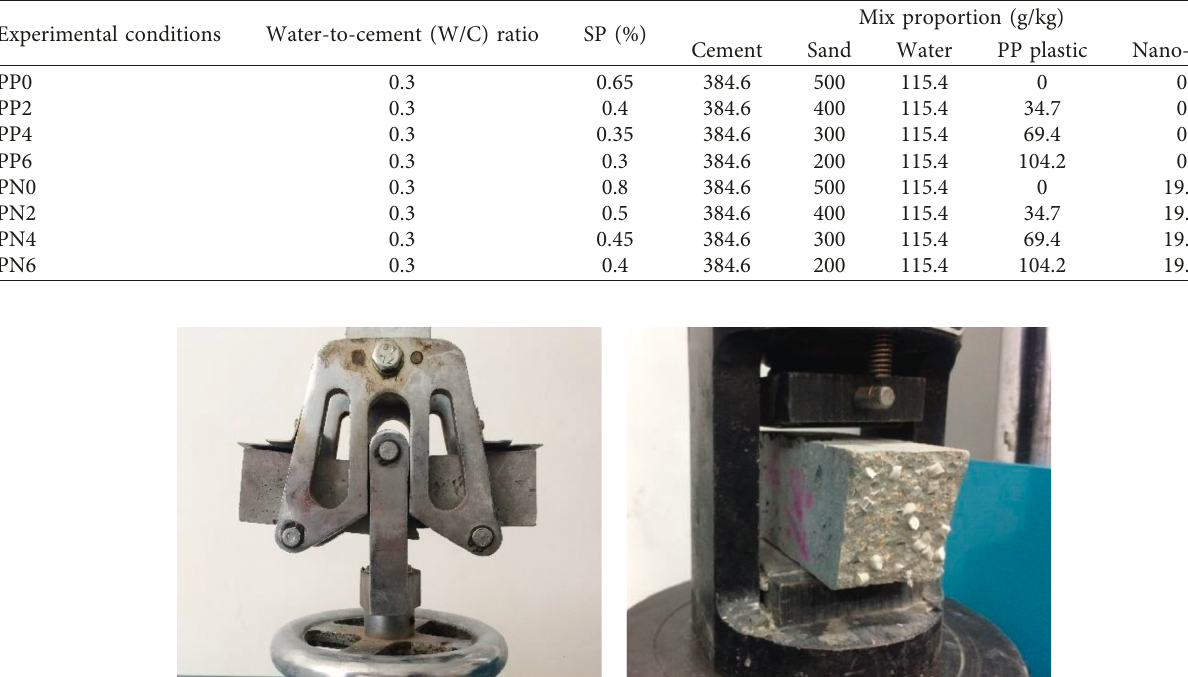
Table 2: Mix proportions of the